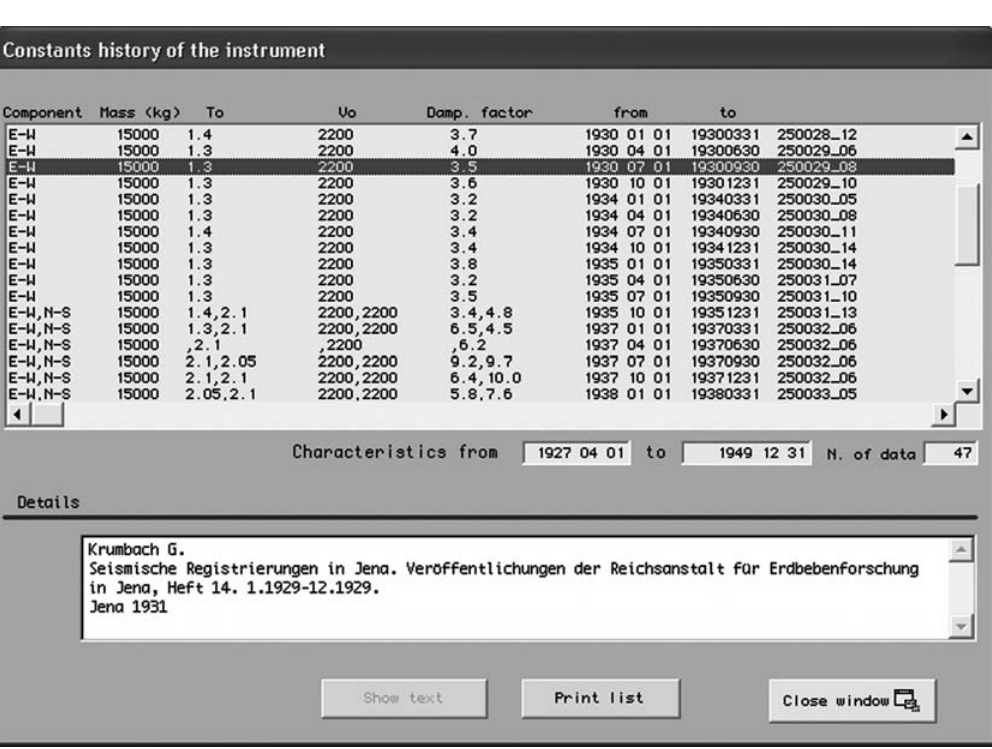
Fig. 7. Instruments seismic constants history file, consultation window of the constant history of the instrument. By selecting a line from the list the related bibliographic reference is highlighted in the text field «Details» at the bottom. By clicking on the button «Show text» the PDF file is opened containing the digital scan of the orig- inal text from which the information have been